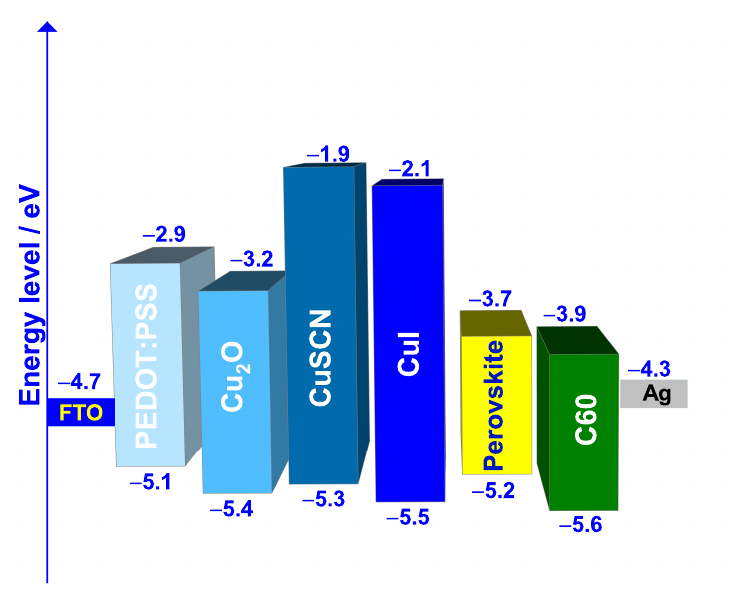
Figure 3. Band alignment between HTL materials and E1G20 perovskite. For a better description of the energy band alignment, the valence band offset (VBO) can be calculated (Equation (4)) using the values of Tables 1 and 2 or Figure 3.